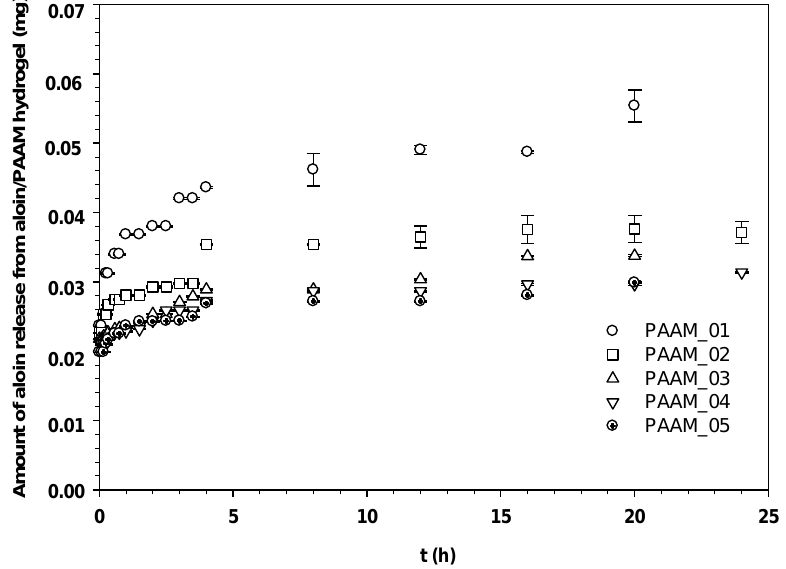
Figure 5. Amounts of aloin released from aloin/PAAM hydrogel at time t vs. t (h) at various crosslinking ratios, E = 0 V, pH = 5.5, and at 37